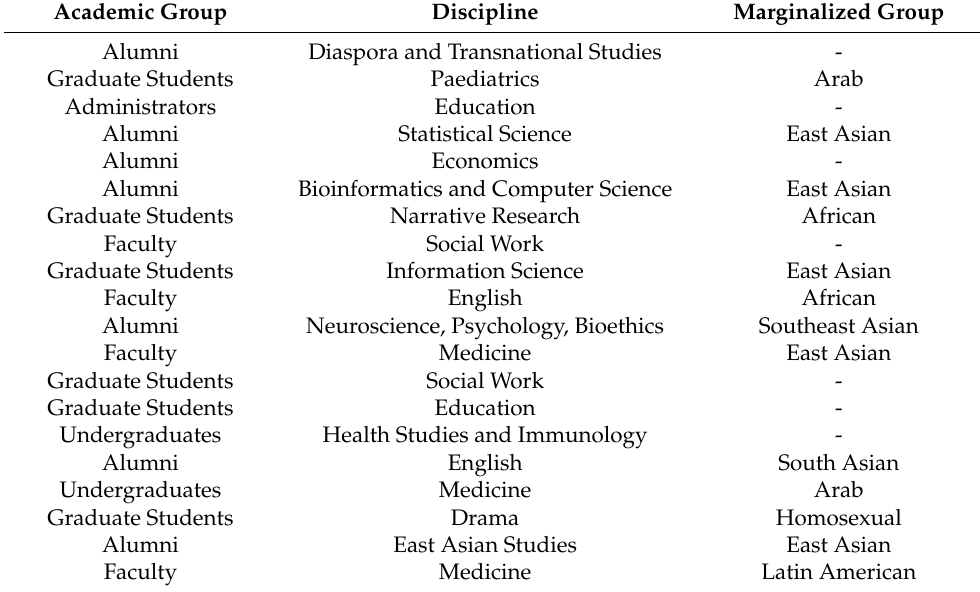
Table 1. Membership to the HeNReG for the 2020/21 academic year by academic group to which each member belongs, their discipline, and if belonging to a marginalized group, from information provided by the researchers’ own accounts. The table presents the diversity of membership with respect to these three